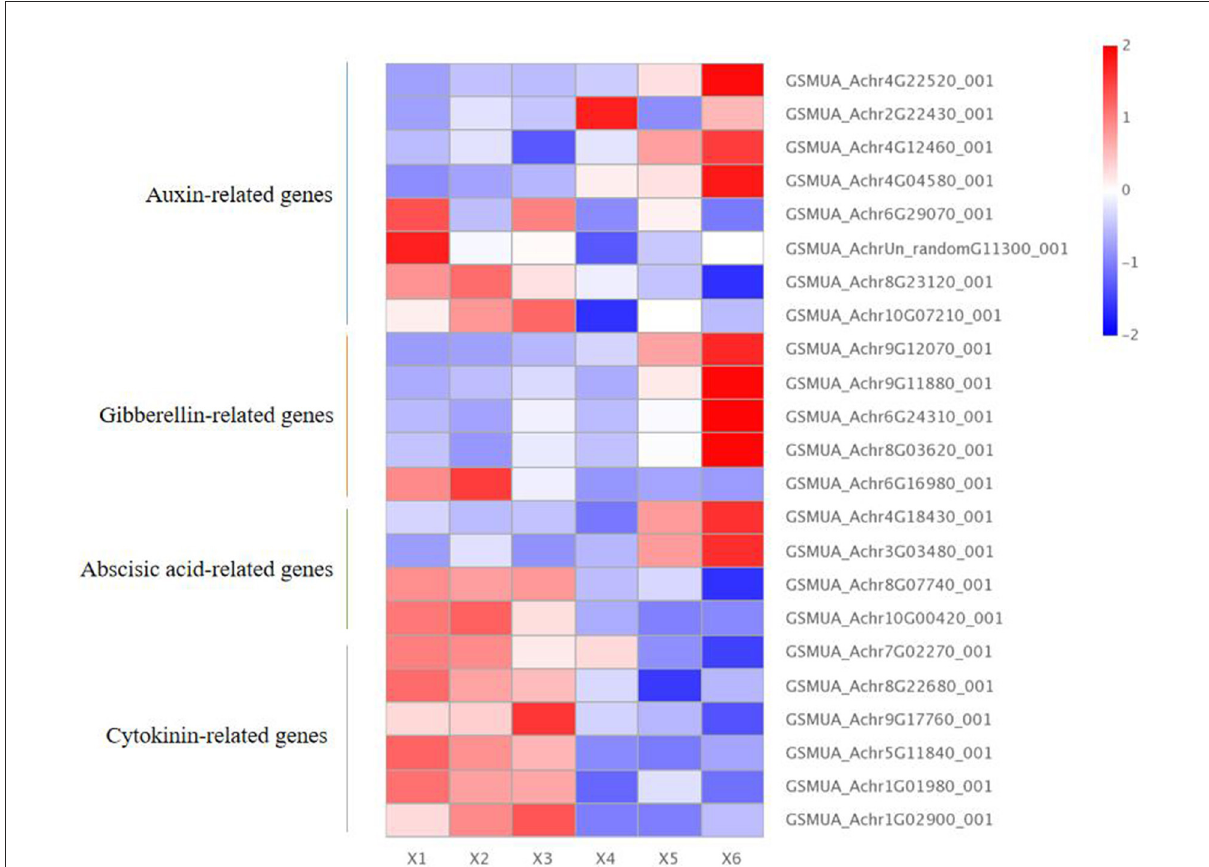
FIGURE5 Endogenous hormone differentially expressed genes in diploid and autotetraploid of Pisang Berlin. X1, X2, and X3 represented the diploid banana plants, and X4, X5, and X6 represented the autotetraploid banana plants.